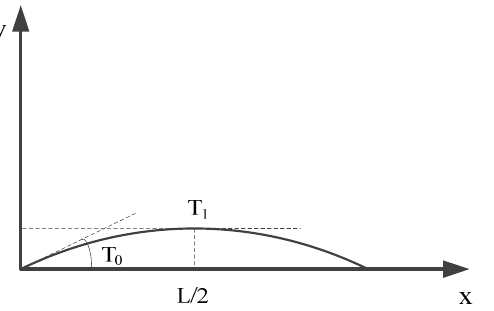
Figure 5. Datum path planning with different geodesic curvature.